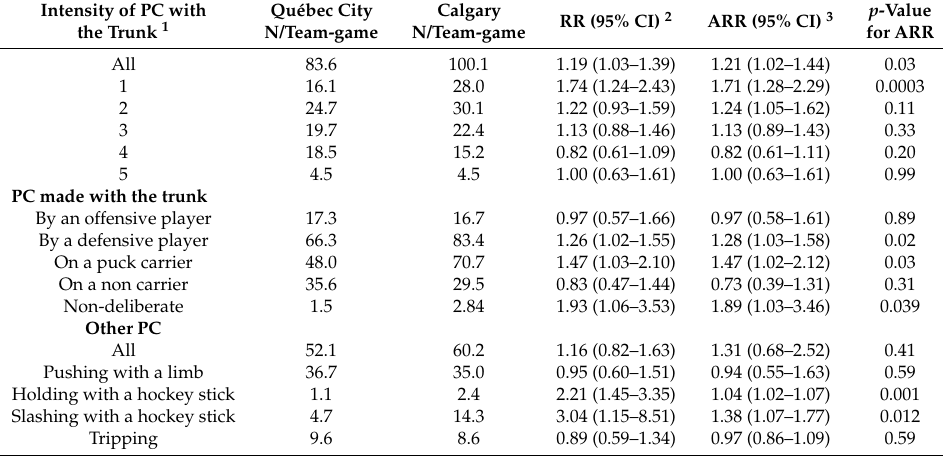
Table 2. Characteristics of the physical contacts (PC) made with the trunk and other PC made by Bantam ice hockey players (13–14 years old) in leagues in Québec City and in leagues in Calgary (2008–2009 season). Intensity of PC with Québec City the Trunk 1